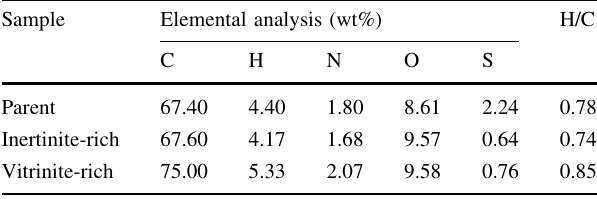
Table 2 Elemental analyses (air dried) for the parent, inertinite-rich, and vitrinite-rich samples Sample